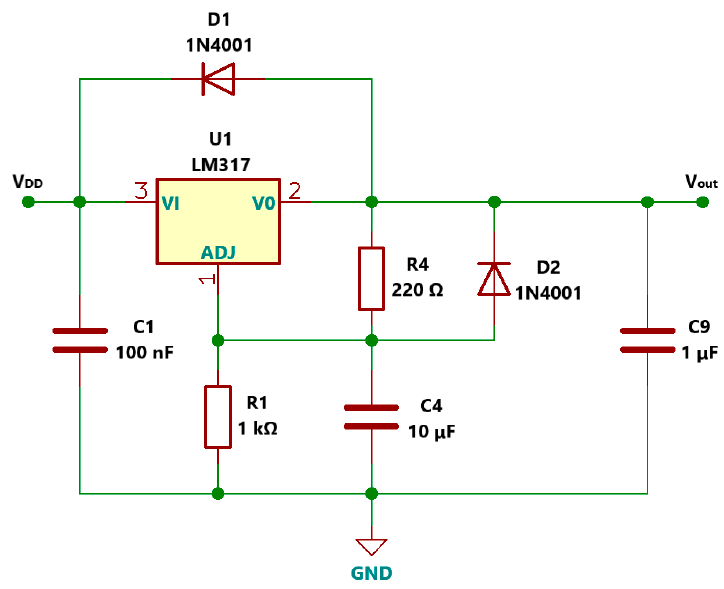
Figure 2. Voltage regulator circuit for Arduino power supply.